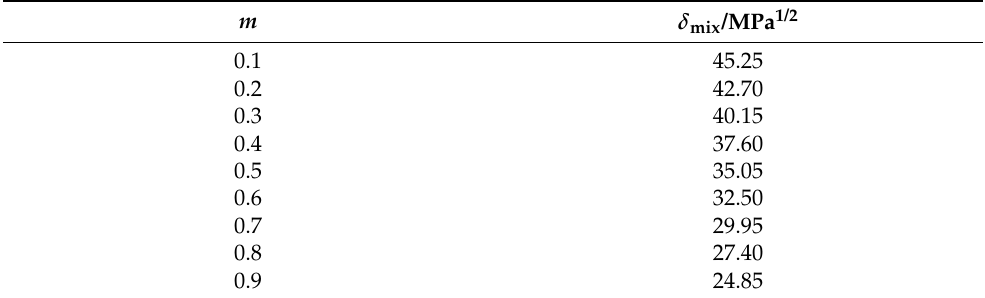
Table 2. Hansen solubility parameters ( δ mix /MPa 1/2 ) for binary (IPA + H 2 O) compositions free of TQ at 298.2 K.